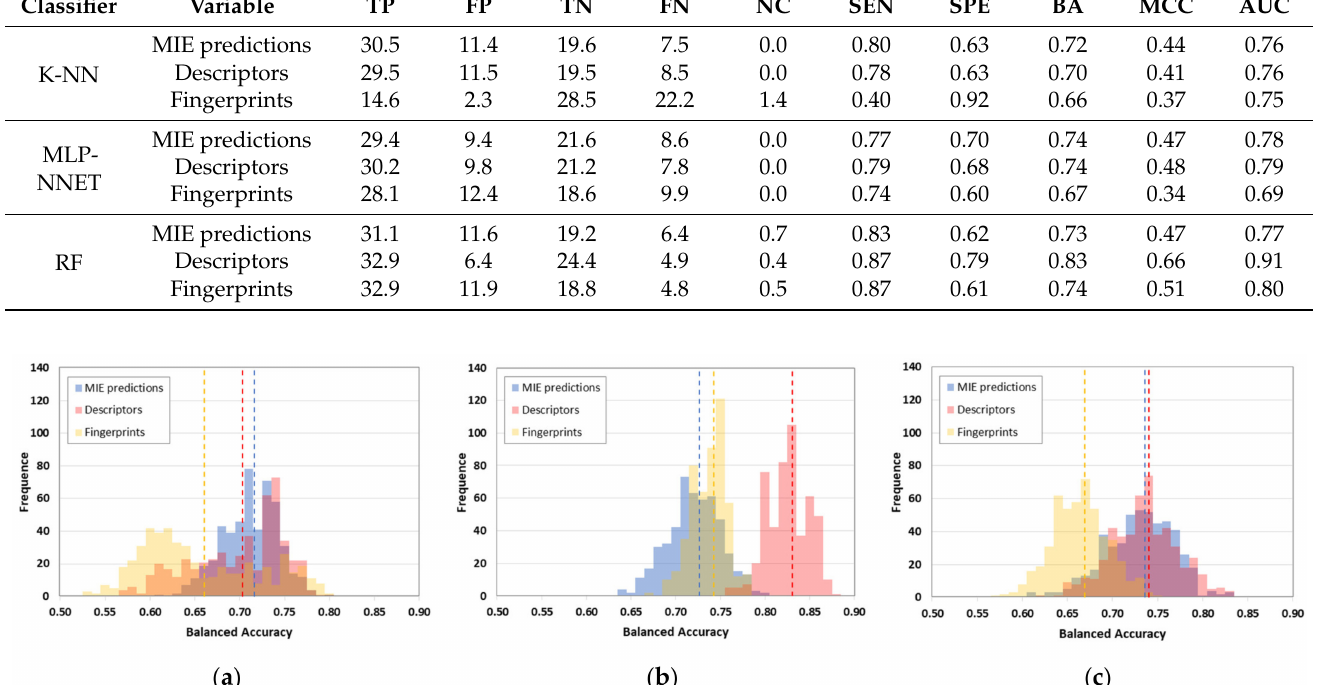
Figure 1. Distribution of balanced accuracies calculated among the various QSARs developed to predict neurotoxic potential. Balanced accuracies are grouped based on the algorithm used: ( a ) k-Nearest Neighbours; ( b ) Random Forest; ( c ) Neural Network. Blue bars refer to models developed based on MIE predictions, red bars refer to models based on DRAGON descriptors, and yellow bars refer to models based on Extended Fingerprints. Dashed lines indicate the mean accuracy value achieved by each group of